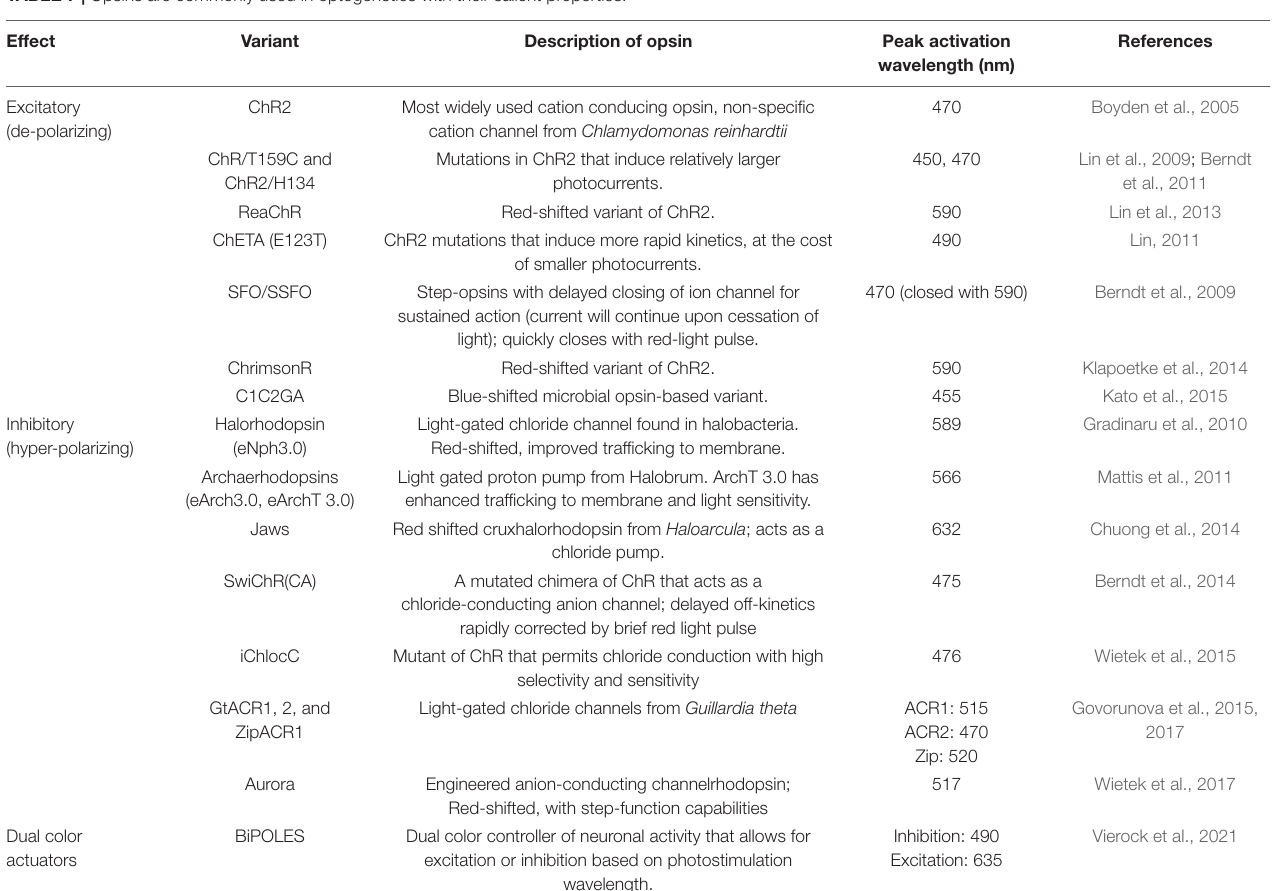
TABLE 7 | Opsins are commonly used in optogenetics with their salient